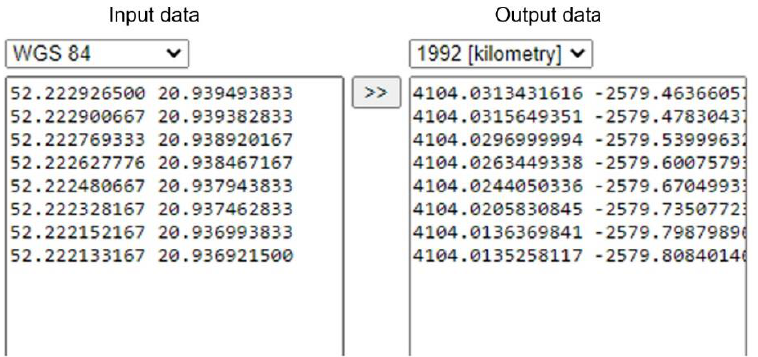
Figure 3. Geographical coordinates conversion.